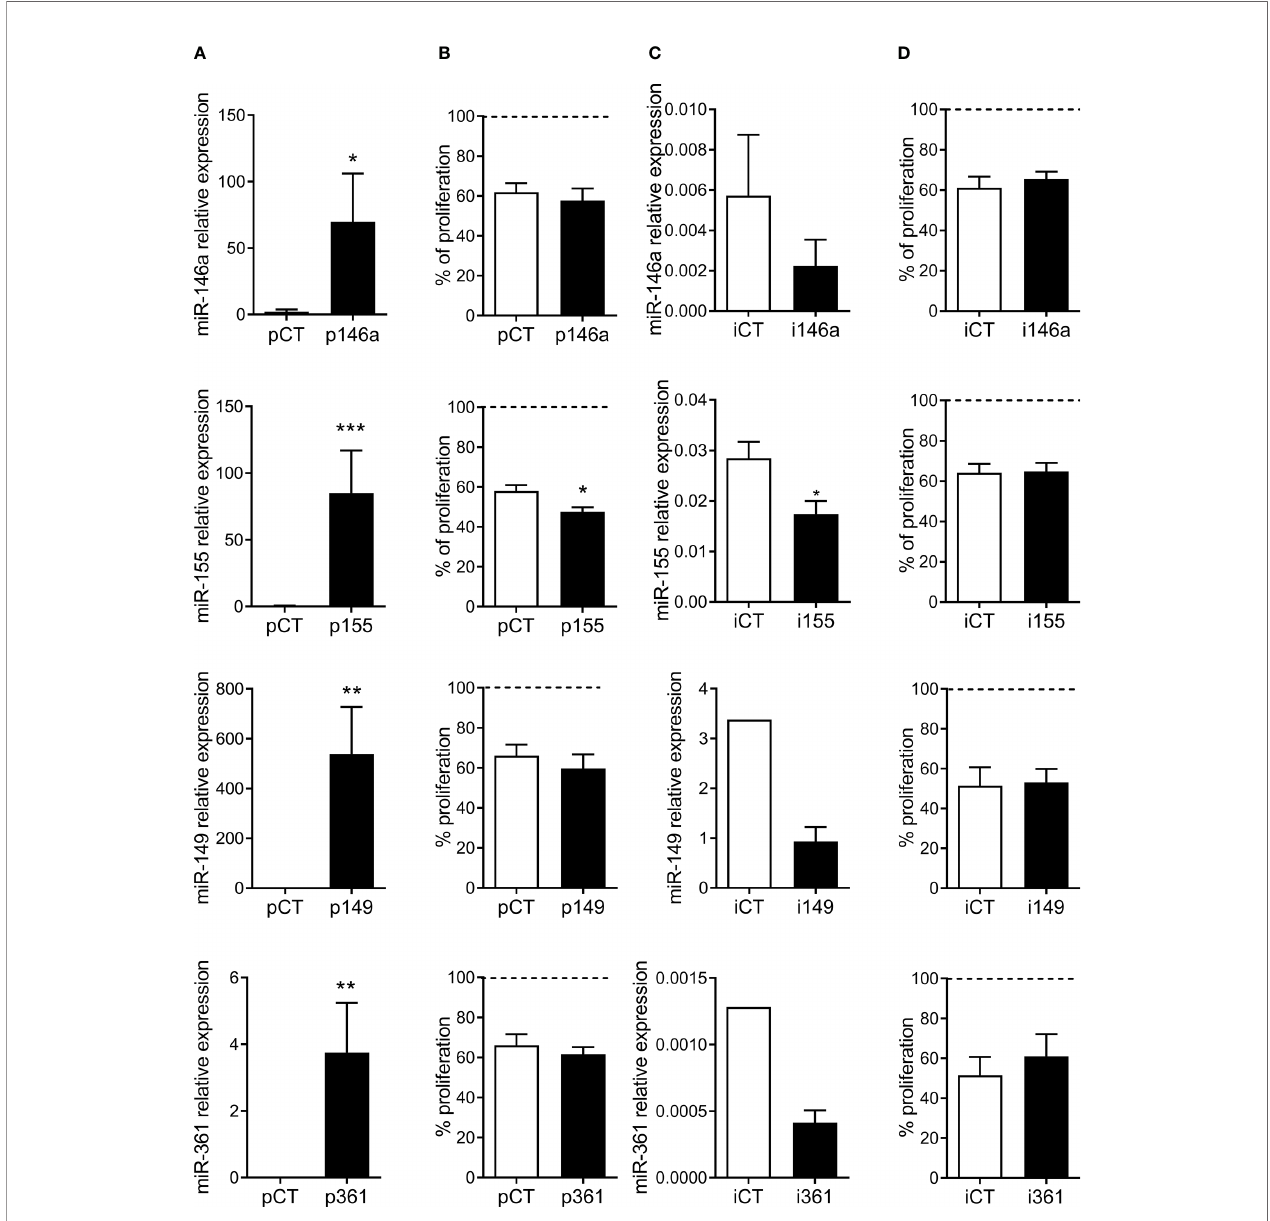
FIGURE 3 | MiR-155 is involved in the immunosuppressive function of MSCs. (A) Relative expression of miR-146a, miR-155, miR-149 and miR-361 in MSCs after transfection of speci fi c premiRNAs (p146a, p155, p149, p361) or premiRNA control (pCT) (n=4-6 biological replicates). (B) Percentage of proliferation of aPBMCs cultured in presence of MSCs transfected with the indicated premiRNAs (n=5-6 biological replicates). (C) Relative expression of miR-146a, miR- 155, miR-149 and miR-361 in MSCs after transfection of speci fi c miRNA inhibitors (i146a, i155, i149, i361) or control RNA inhibitor (iCT) (n=3-4 biological replicates). (D) Percentage of proliferation of aPBMCs cultured in presence of MSCs transfected with the indicated miRNA inhibitors (n=3-5 biological replicates). Results are expressed as percentage of aPBMCs maximal proliferation set at 100%. Statistical analysis used Mann-Whitney test with *p < 0.05; **p < 0.01, ***p <